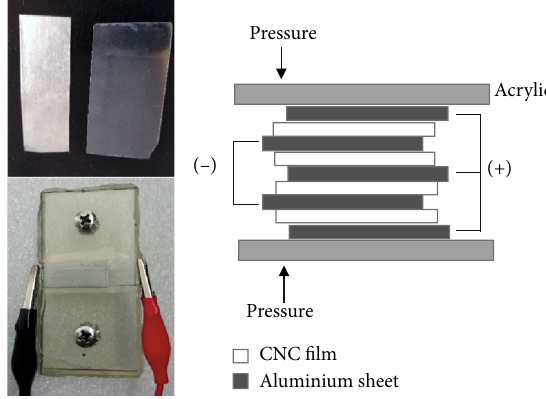
Figure 1: Al sheet, CNC fi lm (dielectric separator), and image of the device and its